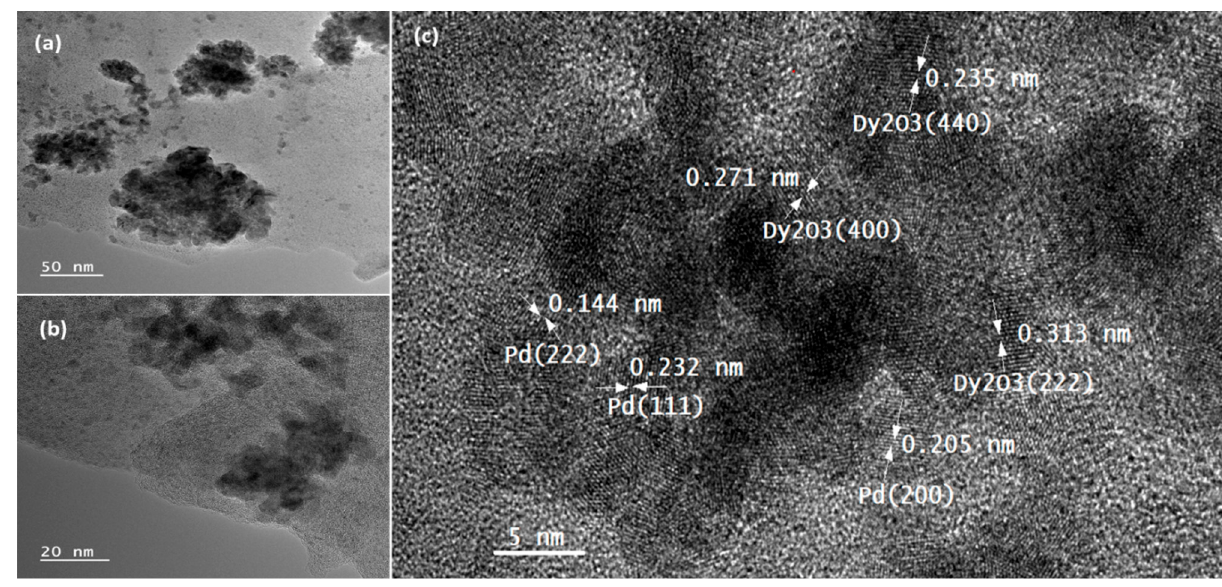
Figure 6. ( a – c ) HRTEM images of Dy 2 O 3 -Pd-PDA/rGO nanocomposite in different magnifications. ( c ) shows interplanar spacings of Pd NPs and Dy 2 O 3 .